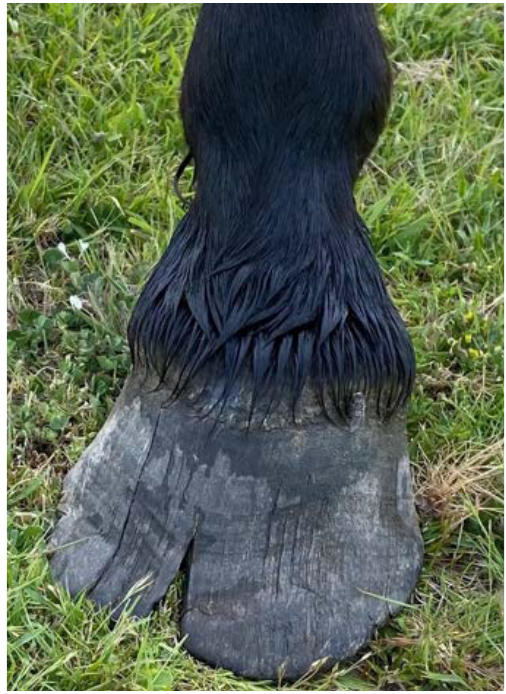
Figure 6. Hoof pathology such as cracks may be common in some populations, but relationship to lameness is not clear. Image A. M. Harvey. lameness is not clear. Image A. M.